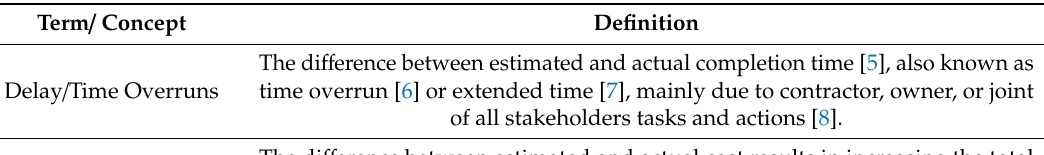
Table 1. Key terms and definitions that may be used in the delay